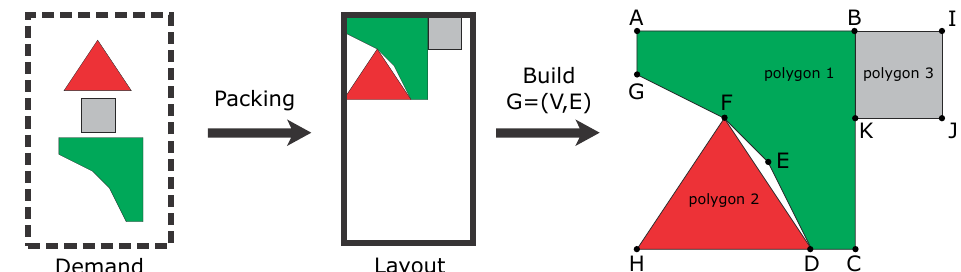
Figure 3. Example of the layout conversion to a set of points in the plane.